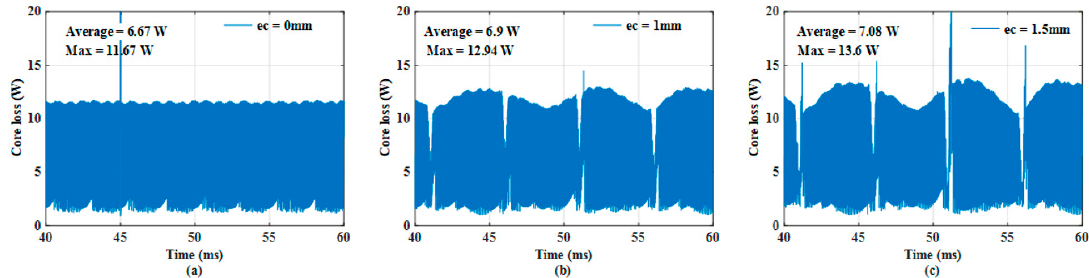
Figure 10. Core loss when harmonics were considered in applied current: ( a ) ec = 0 mm, ( b ) ec = 1 mm, and ( c ) ec = 1.5 mm.